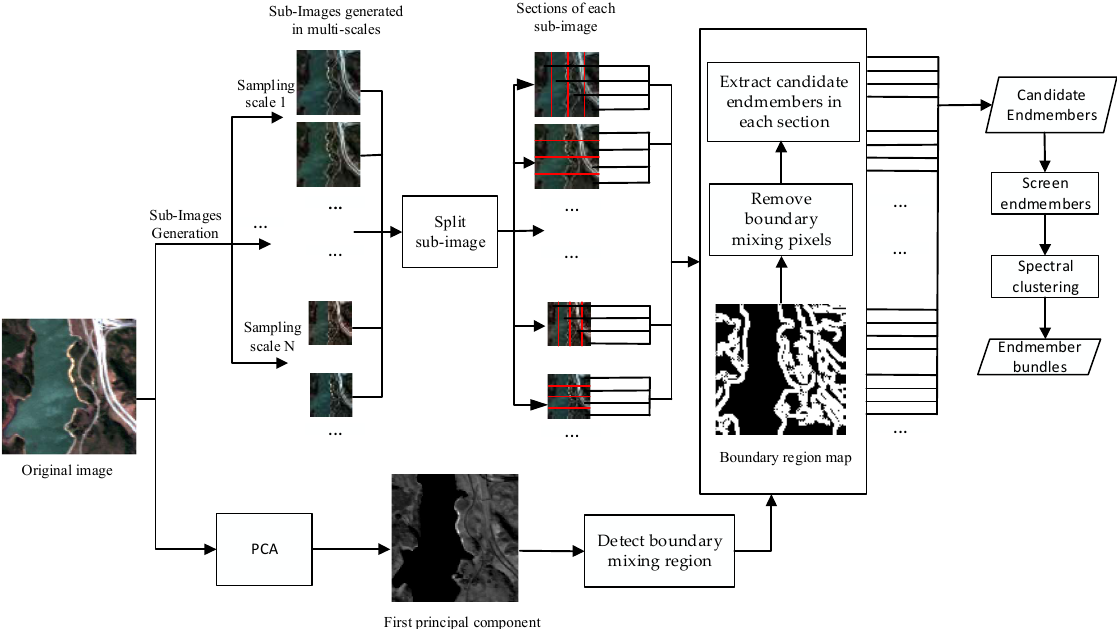
Figure 1. General flowchart of the proposed method for endmember bundle extraction.